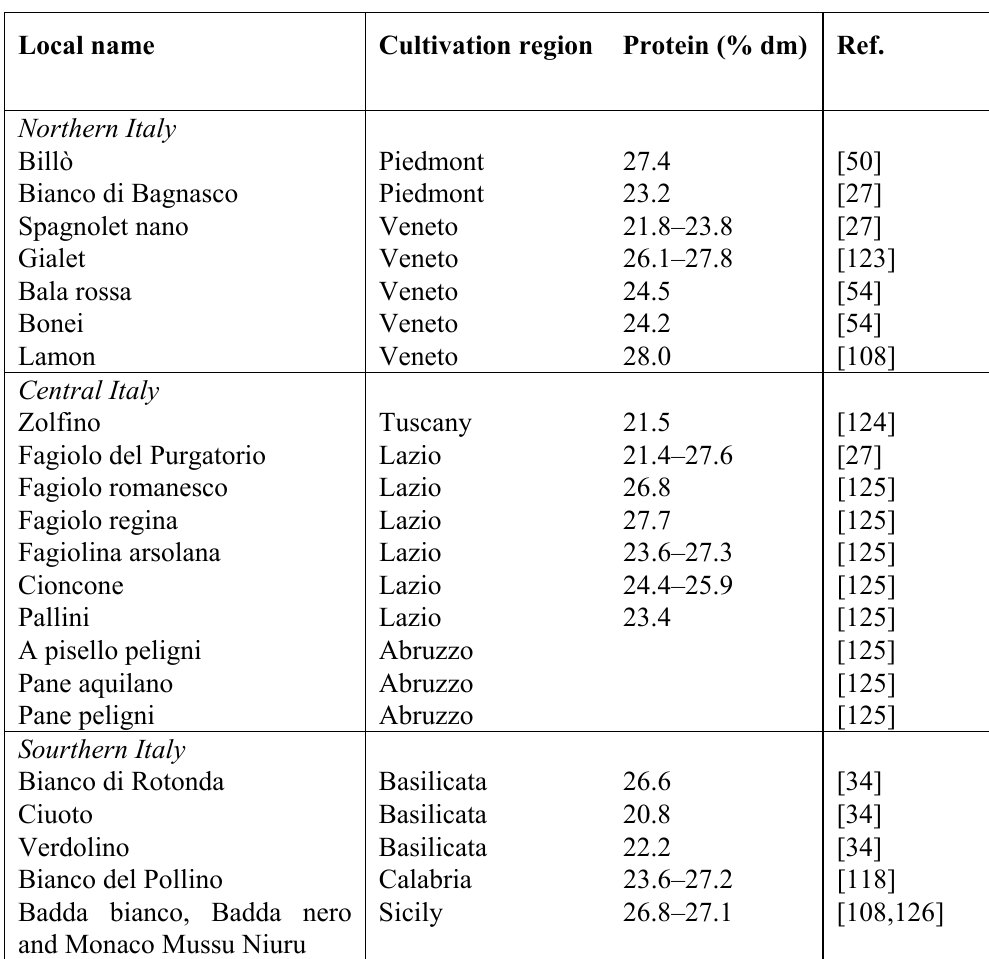
Table 4. Protein content relative to some Italian landraces derived from the literature. A range of values is reported when several populations belonging to the same landrace were